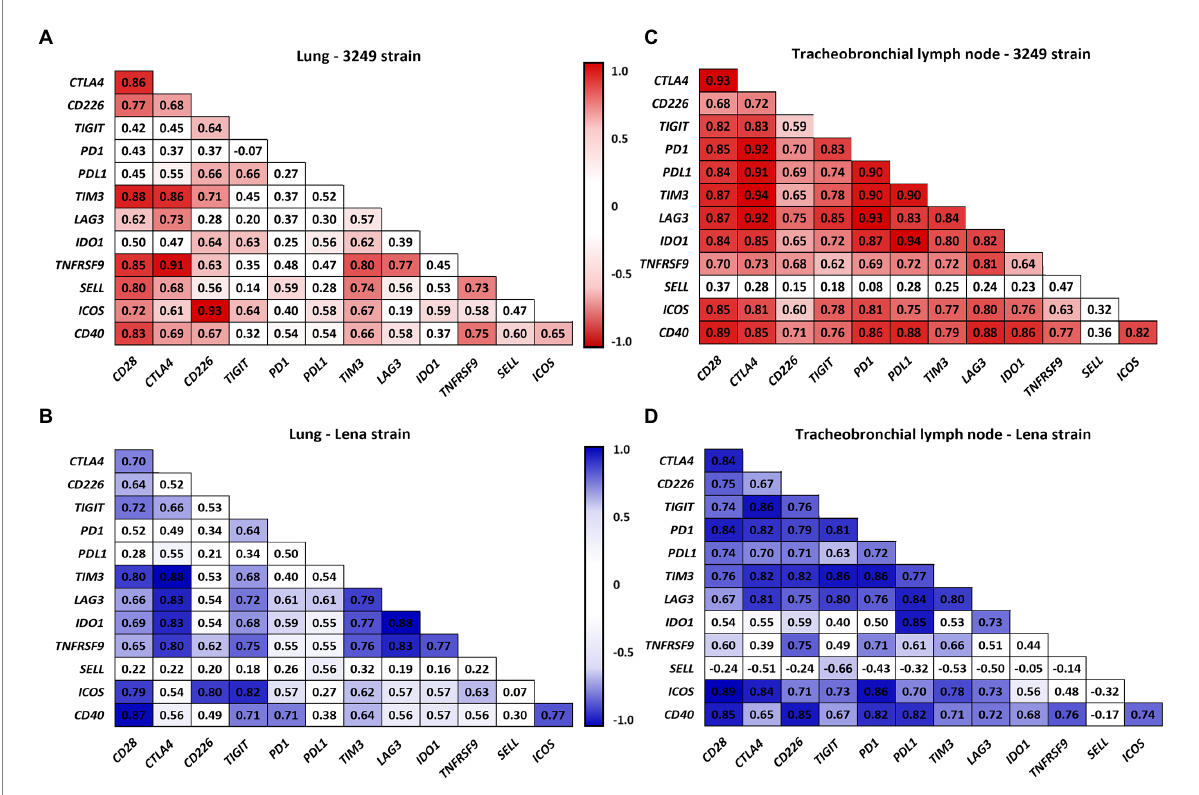
FIGURE 8 Correlation between the expression of immune checkpoints in lung for 3249- (A) and Lena- (B) infected groups and in tracheobronchial lymph node for 3249- (C) and Lena- (D) infected groups are shown. Significant correlations for 3249 and Lena strains are represented with red and blue color, respectively ( ρ > 0.55, p ≤